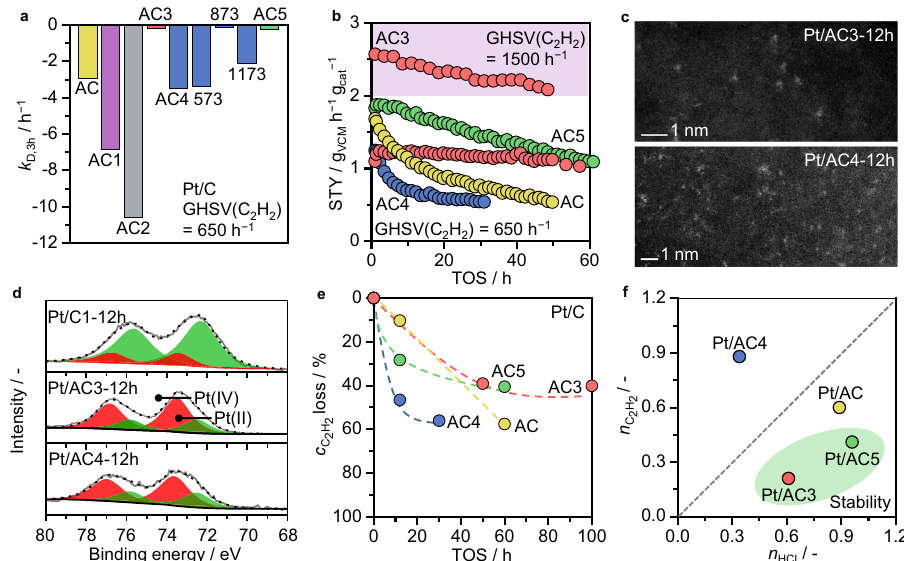
Fig. 3 Stability and deactivation of Pt/C catalysts in acetylene hydrochlorination. a Comparison of the deactivation constants, derived through linear regression of the data range within the fi rst 3 h TOS (Supplementary Fig. 16). b Stability tests under accelerated deactivation conditions, using a GHSV (C 2 H 2 ) of 650 h − 1 and 1500 h − 1 (colored area, AC3). c STEM and d normalized Pt 4 f XPS of used catalysts. e Decrease of the acetylene adsorption capacity, derived from TPD-MS, with TOS. f Partial reaction orders of HCl and C 2 H 2 .